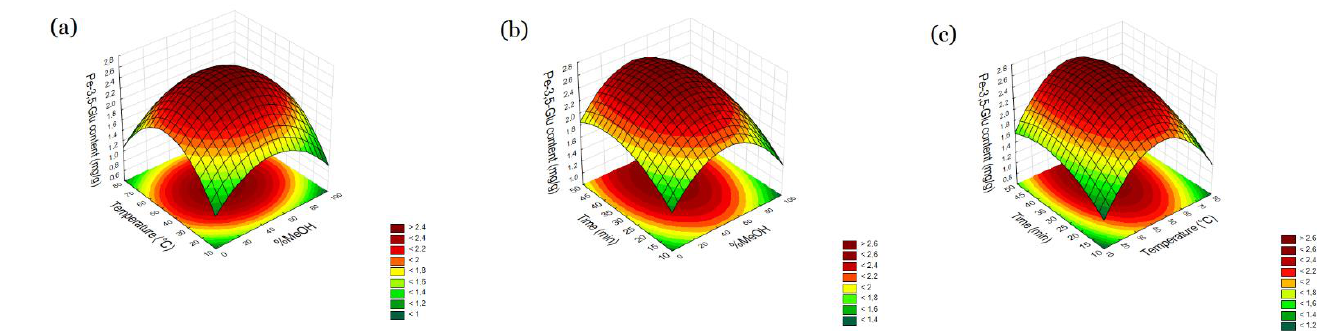
Figure 1. Response surface and contour plots percent of Pel-3,5-Glu content as a function of methanol concentration (X 1 ) and temperature (X 2 ) ( a ), methanol concentration (X 1) and time (X 3 ) ( b ), temperature (X 2 ) and time (X 3 ) ( c ).